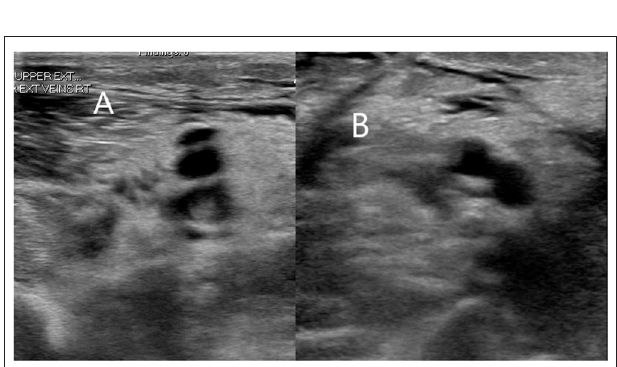
FIGURE 2 | A 70-year-old man in the intensive care unit had right arm swelling after 1 week of diagnosis of COVID-19. Doppler ultrasound of the right arm showing occlusive thrombus within right brachial (A) and basilic veins (B)